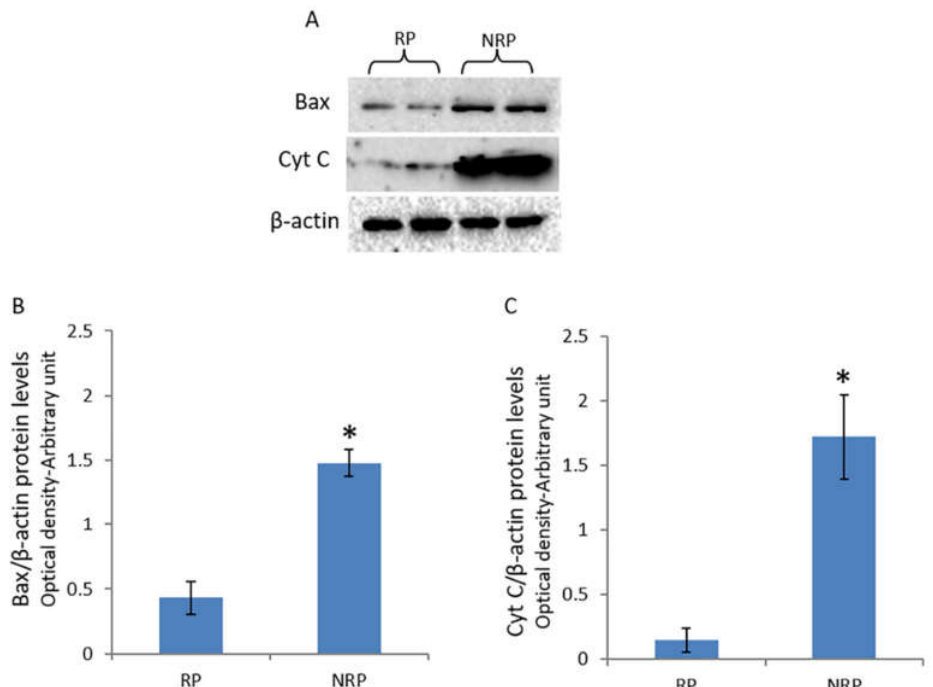
Figure 5. Bax and cytochrome c protein levels in quail testes during reproductive and non- reproductive periods. ( A ) Western blot analysis for Bax (23 kDa) and cytochrome c (14 kDa) proteins in quail testis during reproductive and non-reproductive periods. The amounts of Bax ( B ) and cytochrome c ( C ) were quantified using the ImageJ program and normalized with respect to β -actin. The values presented represent the means ± S.D. of the values obtained for five samples (two bands were shown). * p < 0.05 for reproductive period vs. non-reproductive period. RP, reproductive period; NRP, non-reproductive period.